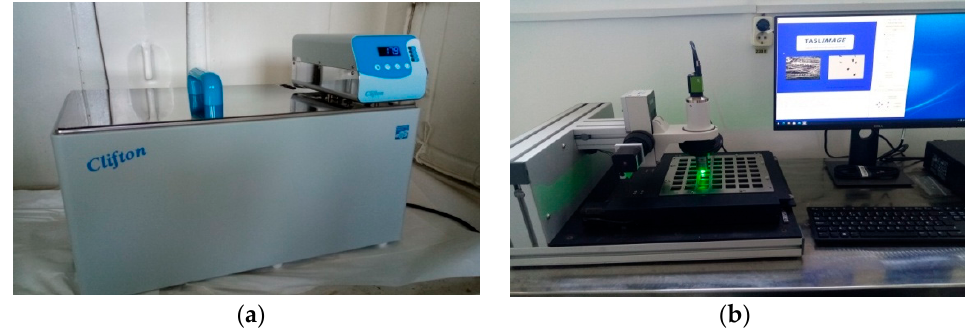
Figure 3. The equipment for etching and optical reading of the TASTRAK detectors exposed to radon: ( a ) the Clifton Digital bath; ( b ) the TASLIMAGE system.